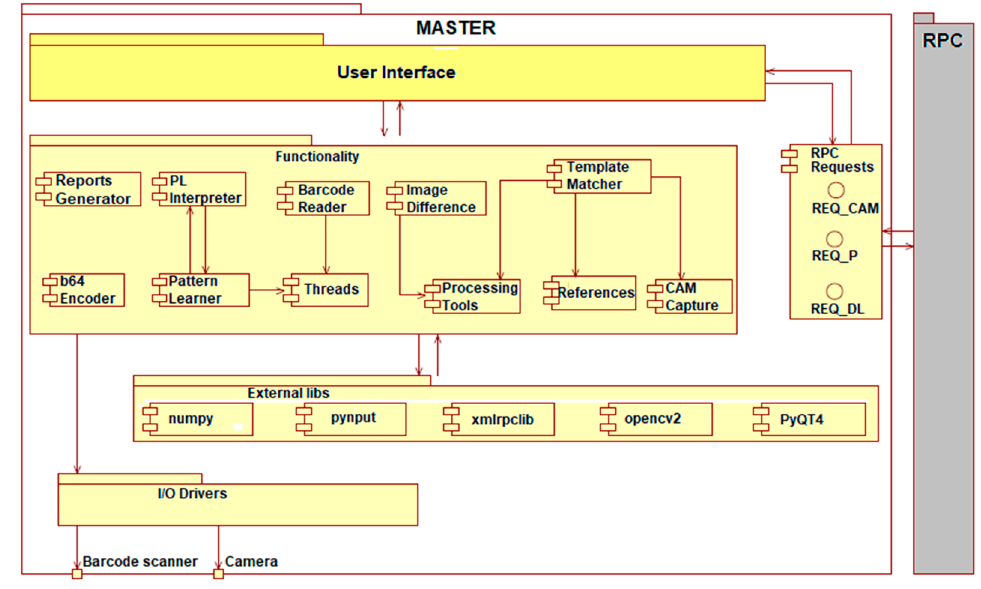
Figure 6. Software architecture of the Master node.